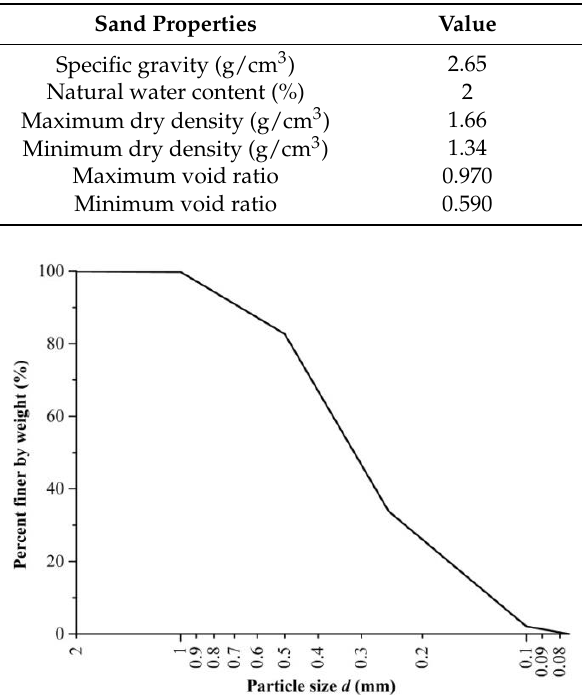
Table 1. Physical Properties of Sand.